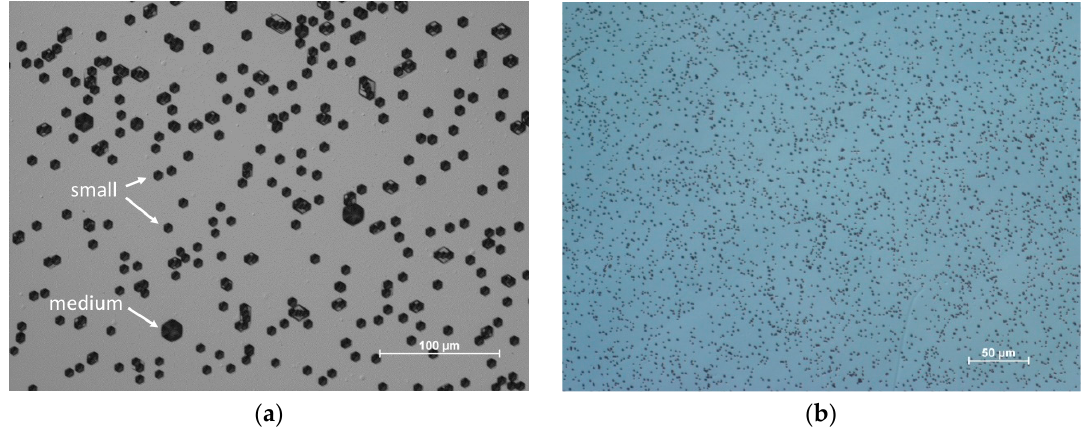
Figure 1. Optical microscope images of (0001) surface (after etching in KOH-NaOH solution at 500 ◦ C) of commercially available 2-inch: ( a ) Am-GaN wafer; medium and small pits visible; EPD = 5 × 10 4 cm − 2 (15 min etching); ( b ) HVPE-GaN; it is difficult to distinguish the size of pits; EPD = 5 × 10 6 cm − 2 (5 min etching; longer time would result in overlapping of pits and lowering the EPD); attention should be paid to different scales on both pictures; difference in pit sizes between ( a ) and ( b ) results from different etching time.